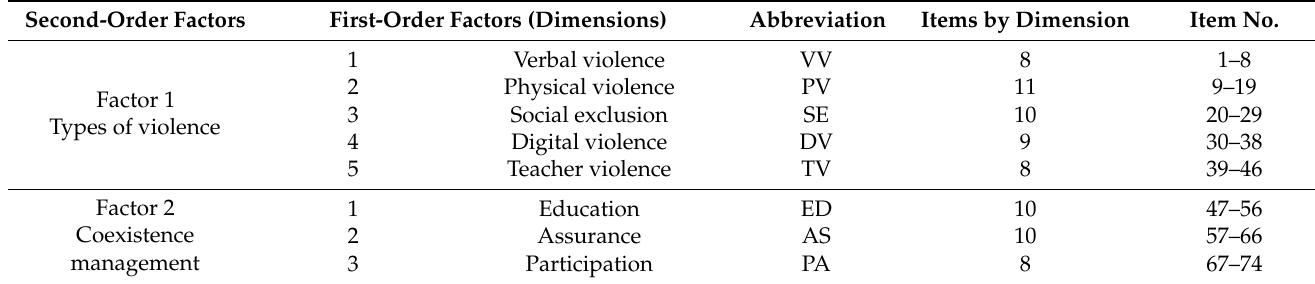
Table 7. Structure of CENVI questionnaire, 74 items. Source: prepared by the authors. Second-Order Factors First-Order Factors (Dimensions) Abbreviation Items by Dimension Item No.